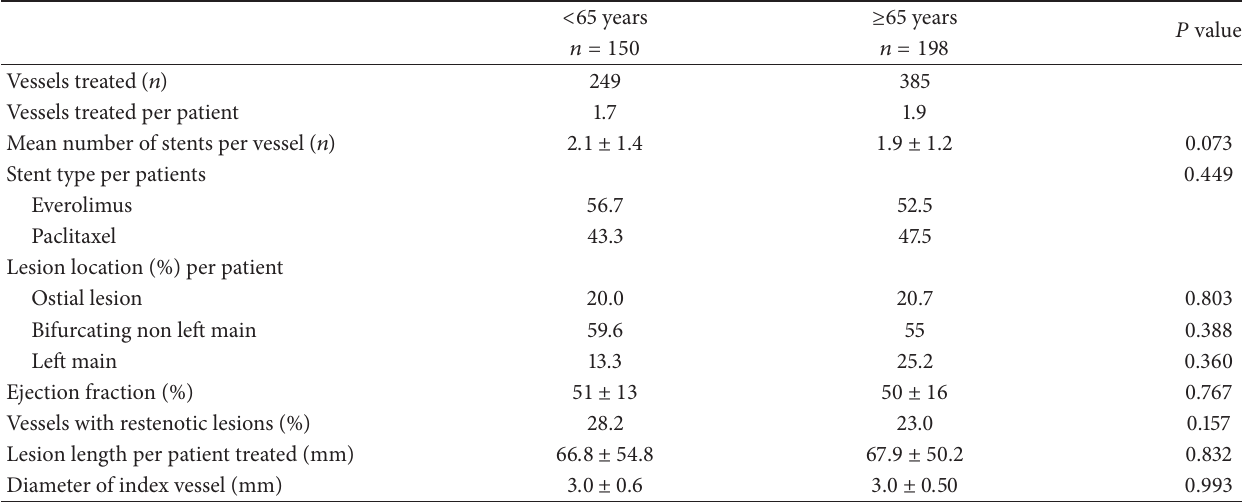
Table 2: Procedural and angiographic